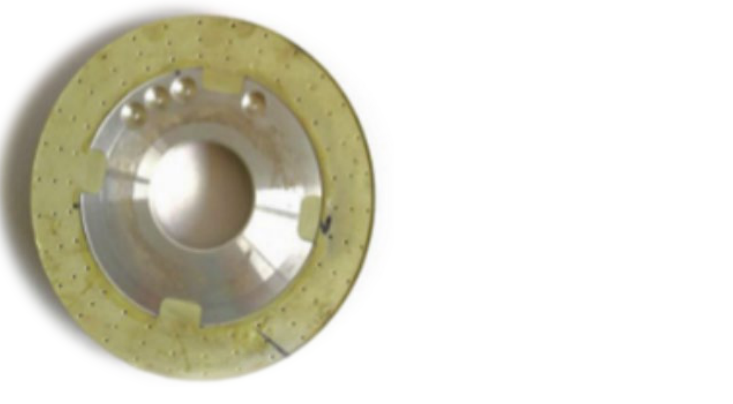
Figure 16. Abrasive grinding wheel with internal cooling holes produced by the SLS method [101].